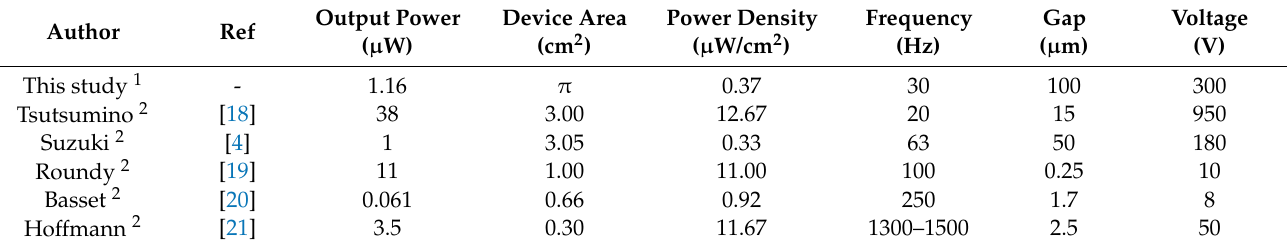
Figure 8. ( a ) The capacitive variation in the rings of s = 100 μ m along the radius of the membrane ( C d , n ) and ( b ) energy output per cycle for the rings of s = 100, 10, and 1 μ m when V bias = 300 V for energy harvesters in the 1st–4th modes. Table 3. Parameters of various electrostatic